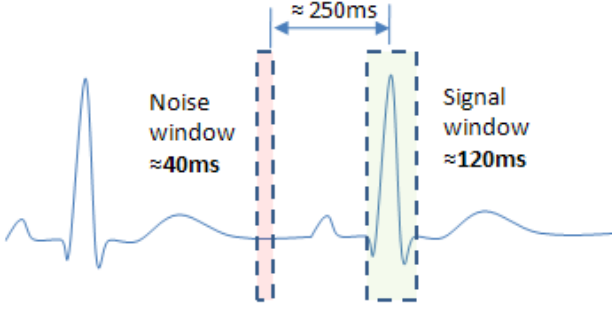
Figure 5. The regions identified above show the area of noise (red) and signal (green) superimposed on an example ECG (electrocardiogram) signal.